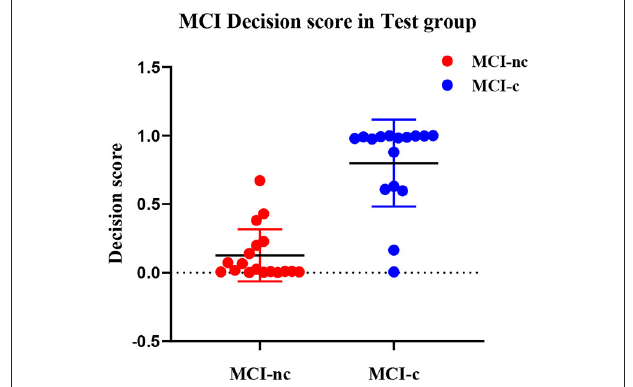
FIGURE 4 | The distribution of decision score of MCI-c and MCI-nc